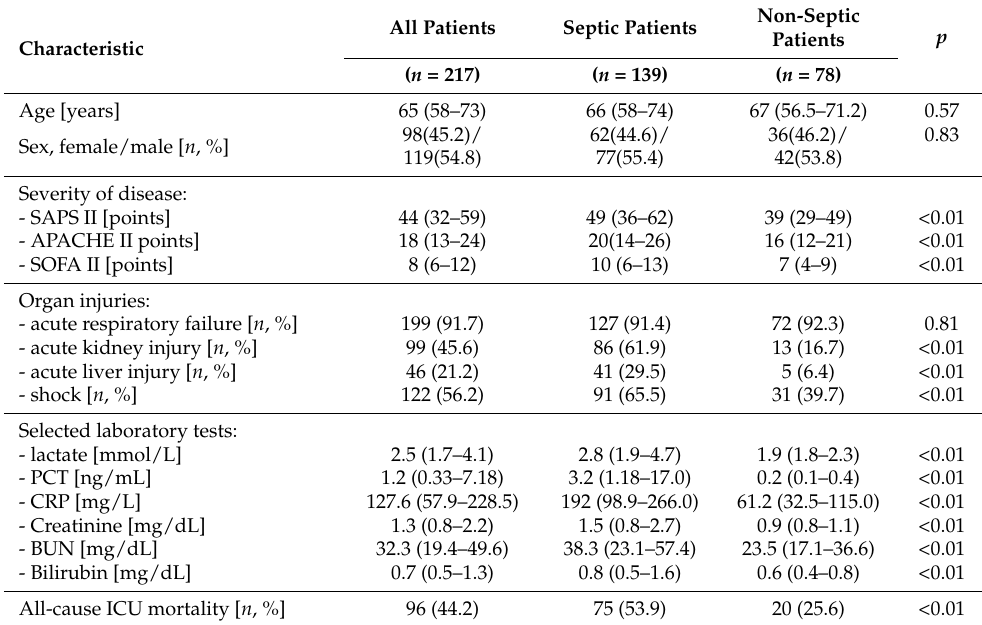
Table 2. Study population characteristics.